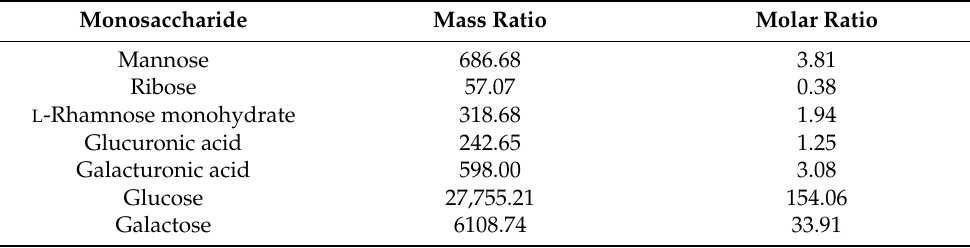
Figure 4. The monosaccharide compositions of RHWPs. Table 4. Mass ratio and the molar ratio of each monosaccharide of RHWPs.